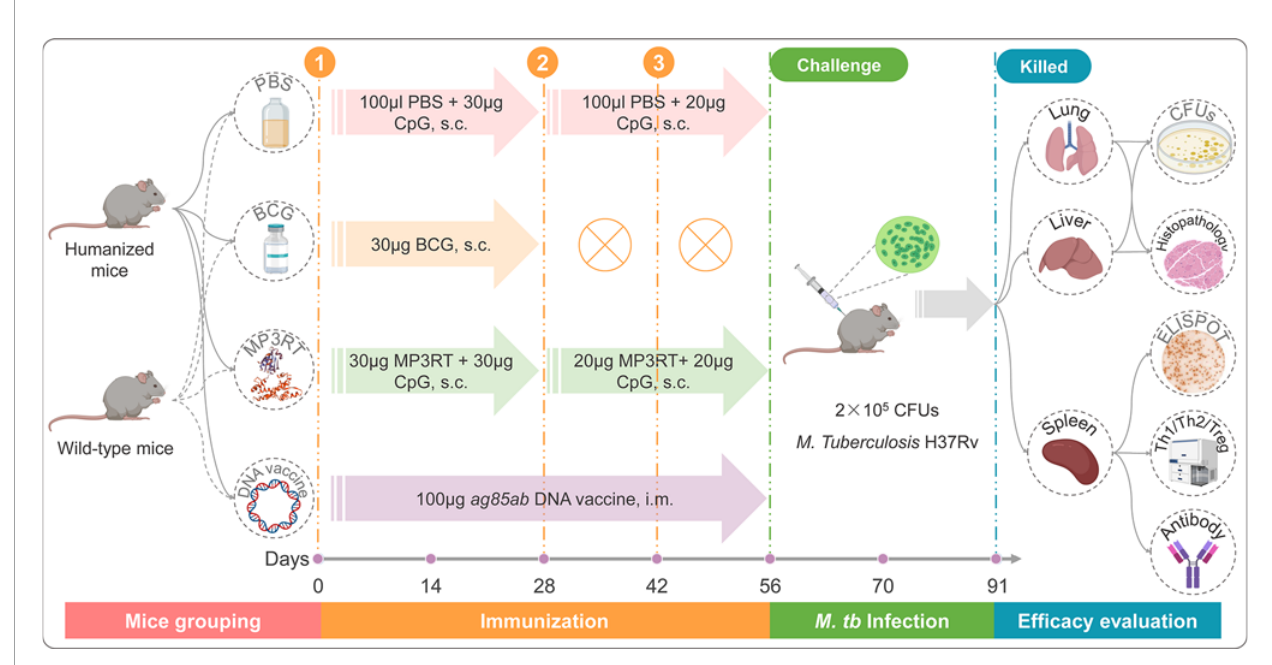
FIGURE 1 | The fl ow chart of vaccination, infection, and